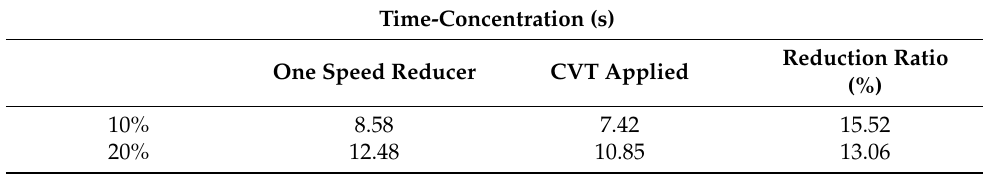
Table 8. Comparison of reduction degree according to speed section when slope is